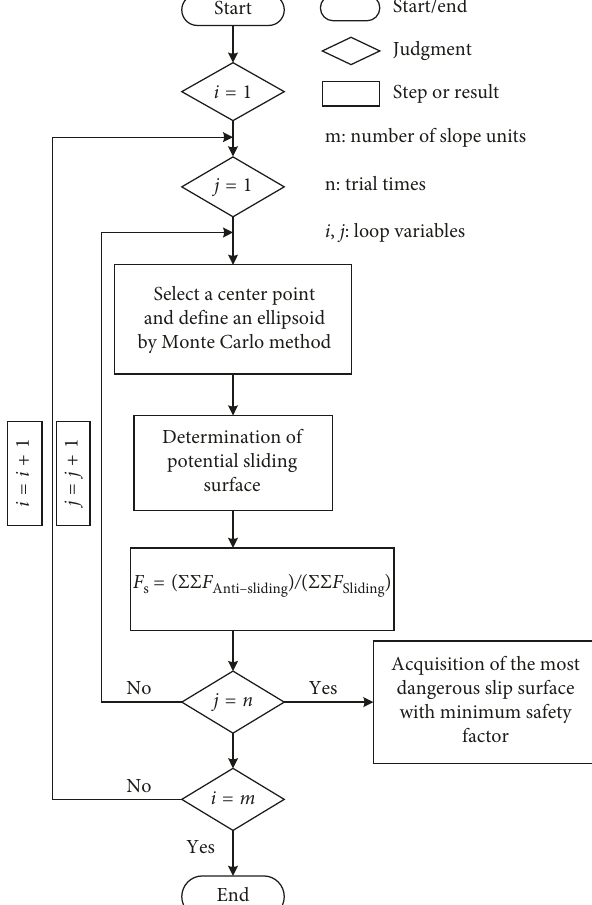
Figure 6: Flowchart of regional integral sliding of slope based on